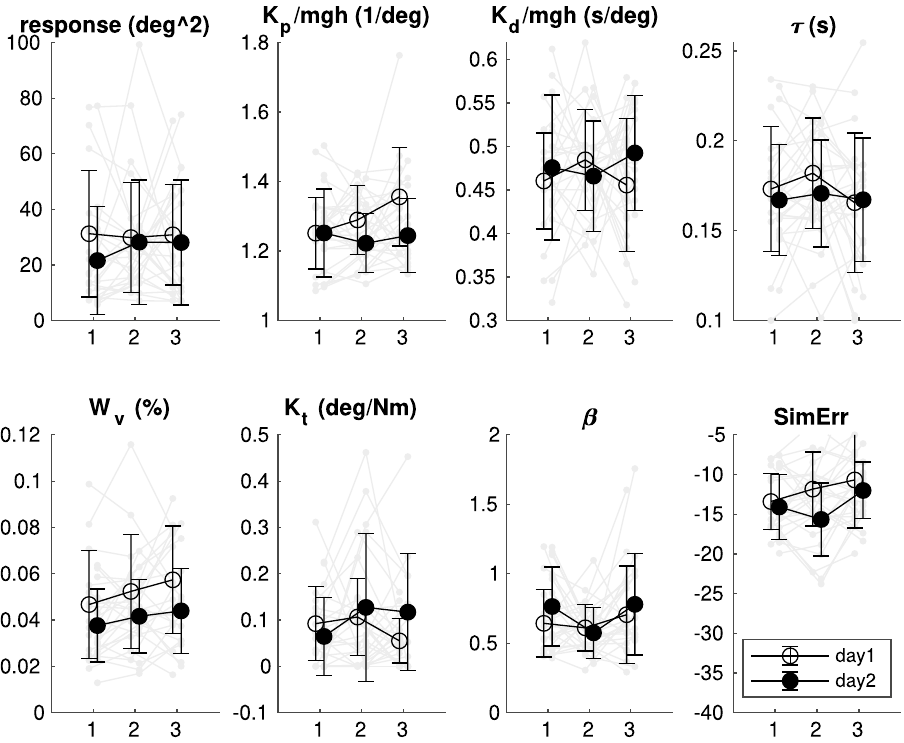
Figure 4. Independent-channel model parameters for each individual short-PRTS condition (pre1, pre2, post as 1–3 on x-axis). In addition also descriptive sway response power, variance parameter β and simulation error (SimErr) are displayed. Parameters are shown for each individual subject (grey) and the across-subject mean, and standard deviation. K p and K d are normalized by mgh.